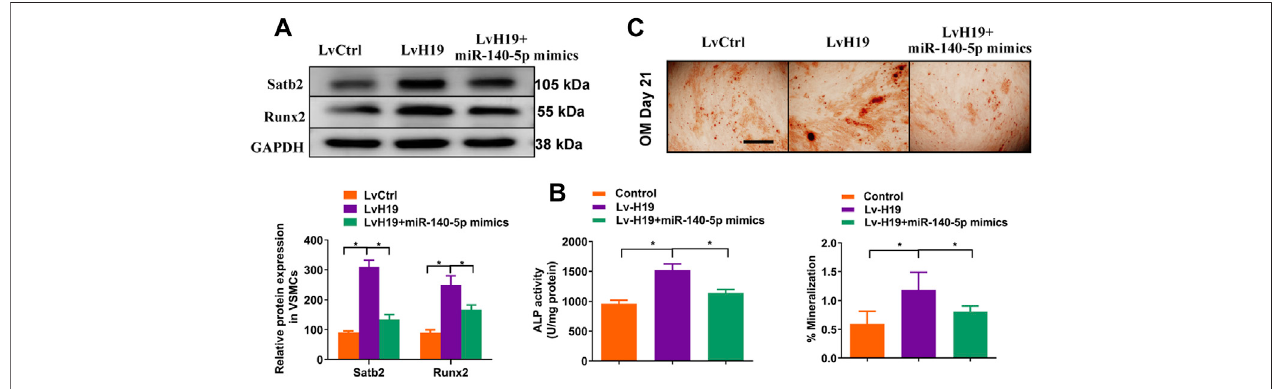
FIGURE 6 | H19 promotes osteogenic differentiation of VSMCs by sponging miR-140-5p. VSMCs were transfected with LvH19, miR-140-5p, or corresponding negative control. (A) Western blotting was performed to evaluate Satb2 and Runx2 expression. The data were presented as densitometric ratios normalized to GAPDH [ (A) ,lowerpanel]. (B) TheALPactivity wasdeterminedbyanElisakit. (C) AlizarinRedSstainingweremeasured in ß -GP-treatedVSMCsinfected withLvCtrlorLvH19 in the presence ofmiR-140-5p mimics or not for 21 days. Representative microscopic views are shown. Scale bar represents 200 µm. Data were presented as ratio of positive staining area [ (C) , lower panel]. Each experiment was repeated for three times. The data represent the mean ± SD of triplicates. * p < 0.05.